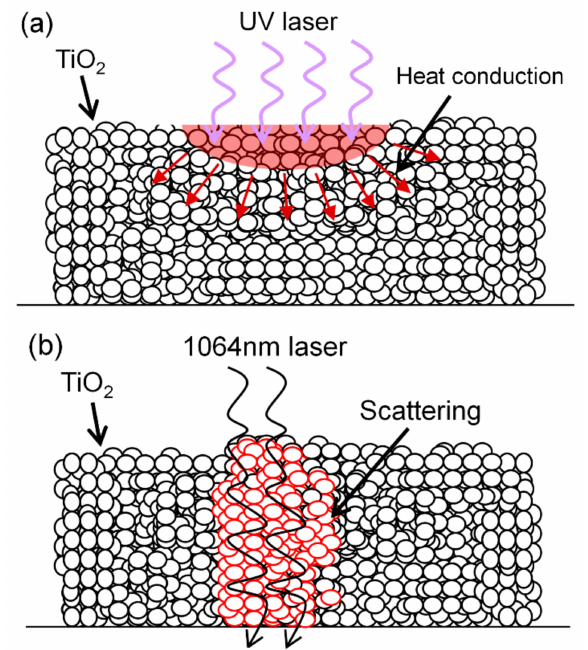
Figure 6. Schematic diagrams of the laser sintering with the wavelength of ( a ) 355 nm and ( b ) 1064